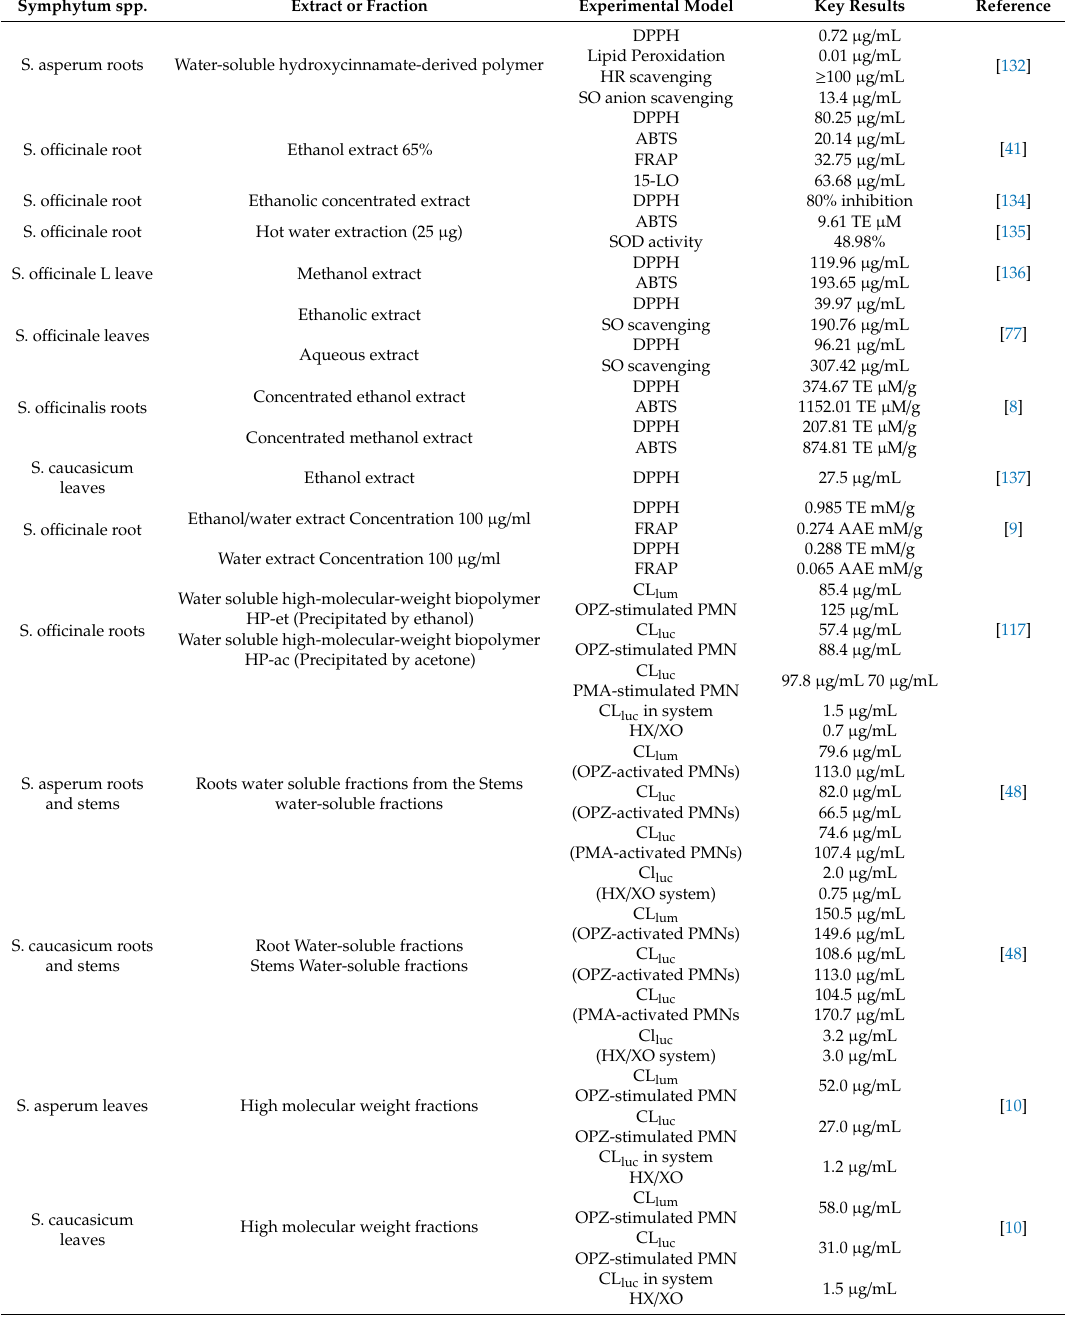
Table 5. Antioxidant e ff ect of di ff erent Symphytum species. Symphytum